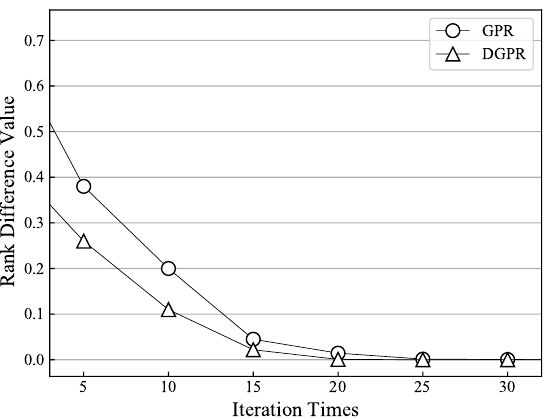
Figure 13. Results of convergence comparison between DGPR algorithm and GPR algorithm.